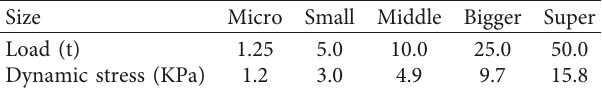
Table 4: Vertical stress of roadbed of 5 different size vehicle